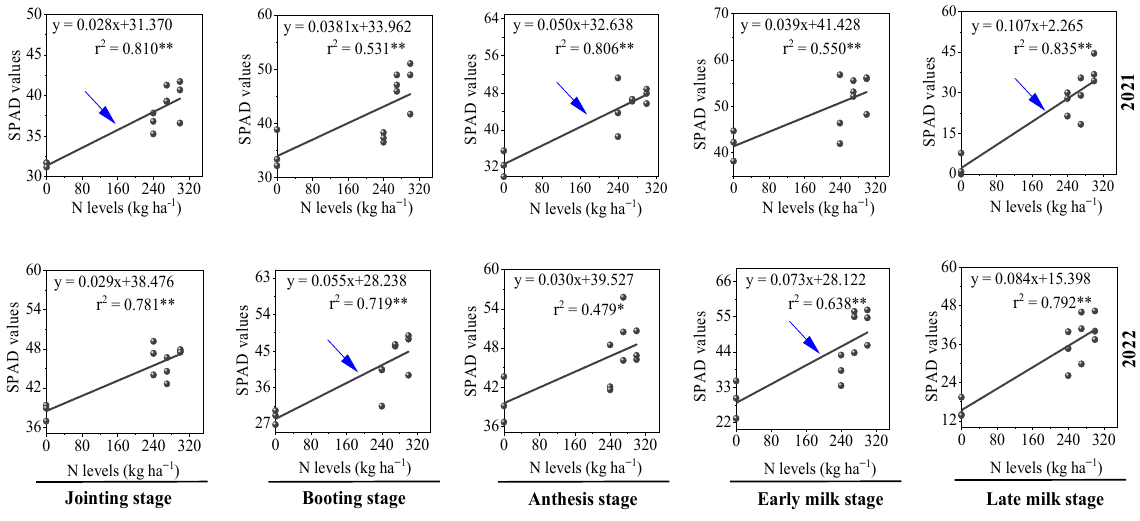
Figure 5. The relationship between SPAD values and N application levels at different growth stages of wheat. The SPAD values were measured in the L1–M of wheat. * and ** indicate significant differences at 0.05 and 0.01 levels, respectively. Blue arrows represent the function that has the higher correlation coefficient (r 2 ) between SPAD values and N application levels at the same growth stage in different years.